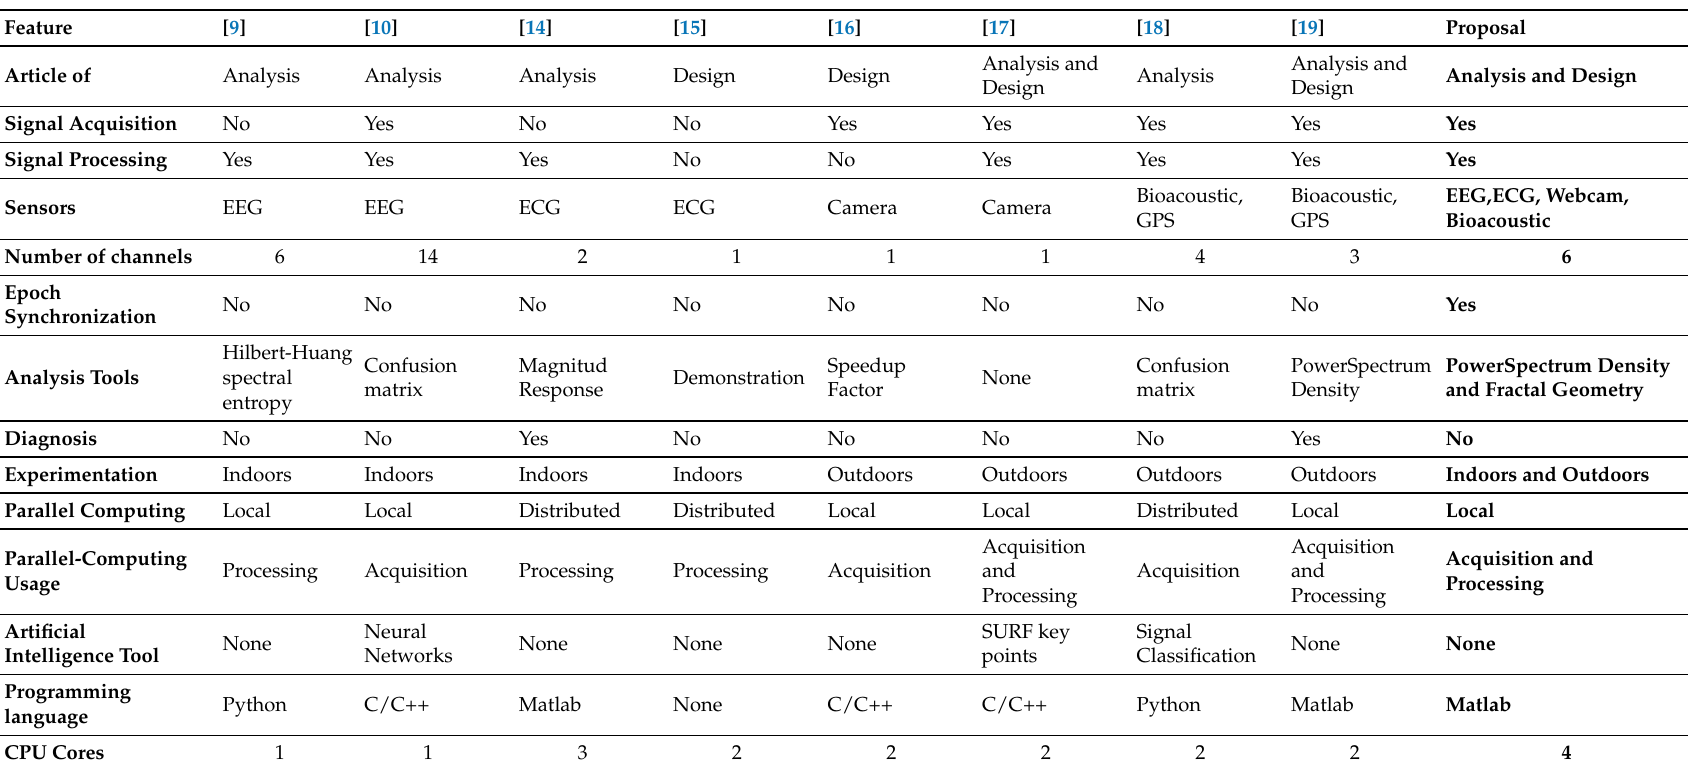
Table 1. Comparison of the present proposal (in bold) with the existing works in the